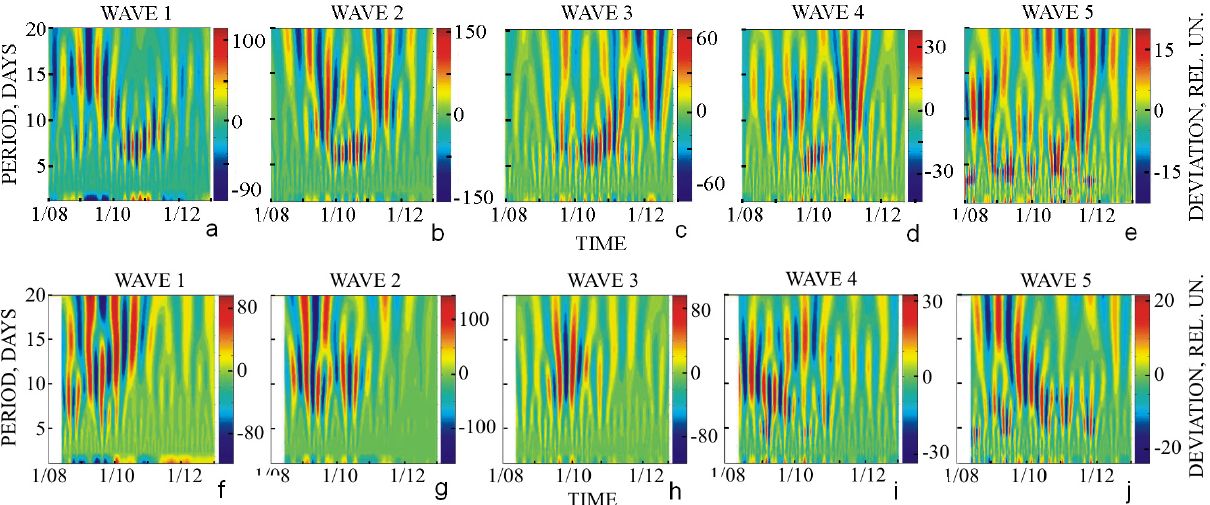
Fig. 3. The periodicity variations of wave numbers 1–5 during August-December 1996 (a–e) and 2002 (f–j).